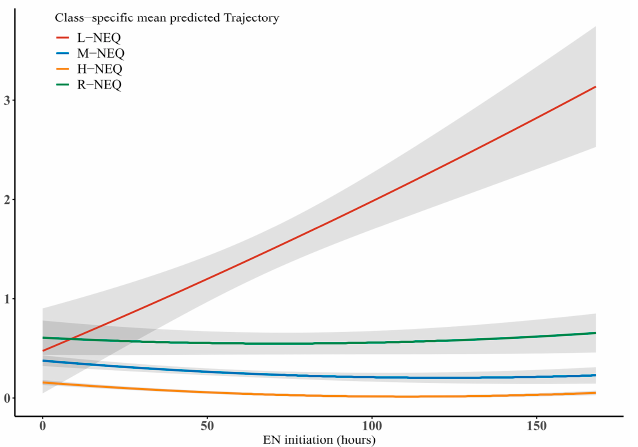
Figure 2. Trajectories of NEQ use in patients with shock after EN initiation. NEQ, norepinephrine equivalent dose; EN, enteral nutrition.